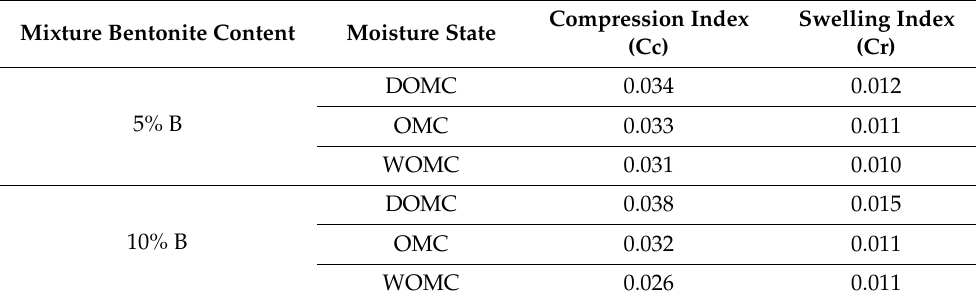
Table 3. Compression and swell index properties of clay–sand mixtures